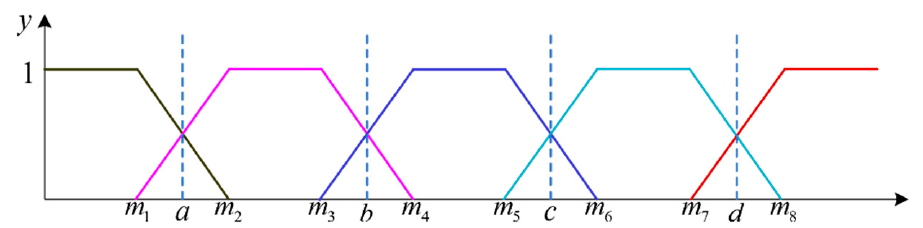
Figure 8. Trapezoidal membership function of traffic congestion levels.